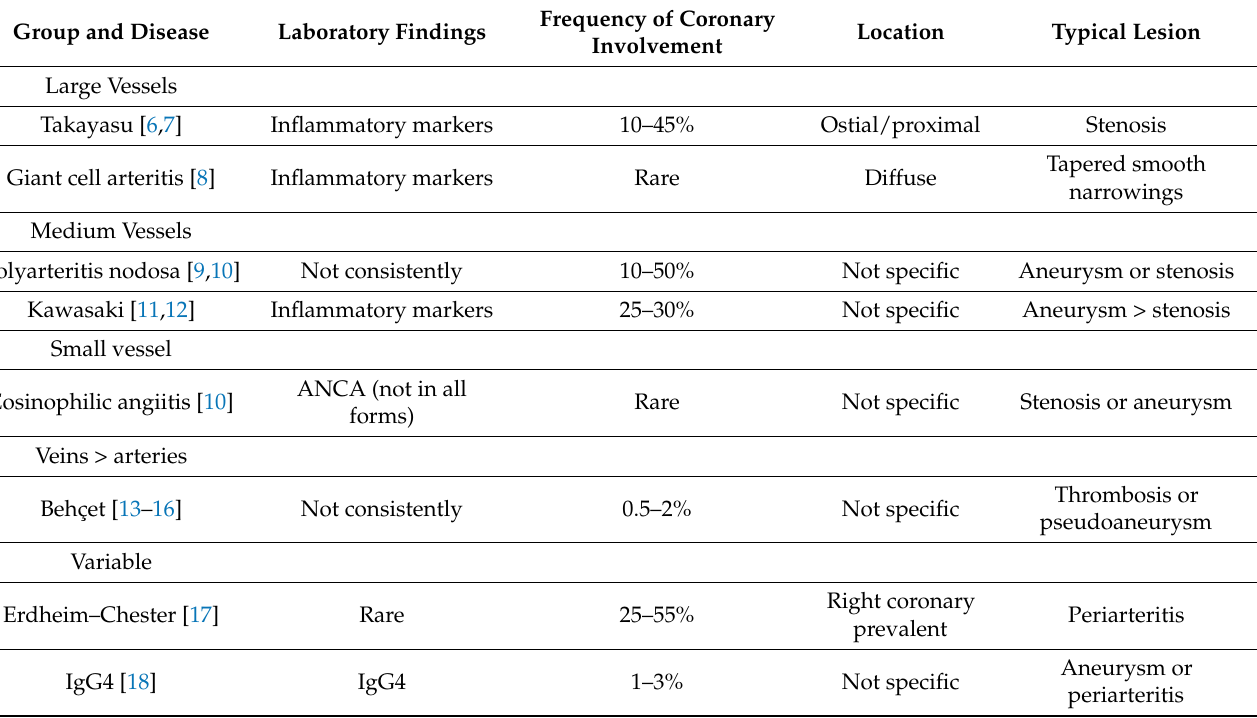
Table 1. Typical forms of vasculitis with coronary